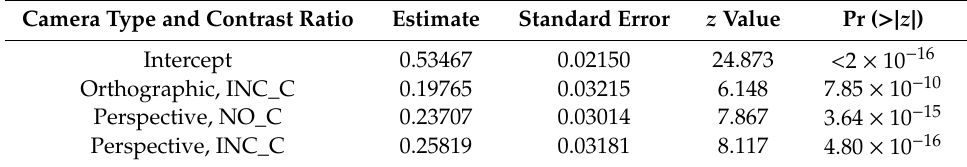
Table 13. Logistic regression analysis results of the e ff ects by pairing the camera type and contrast ratio.